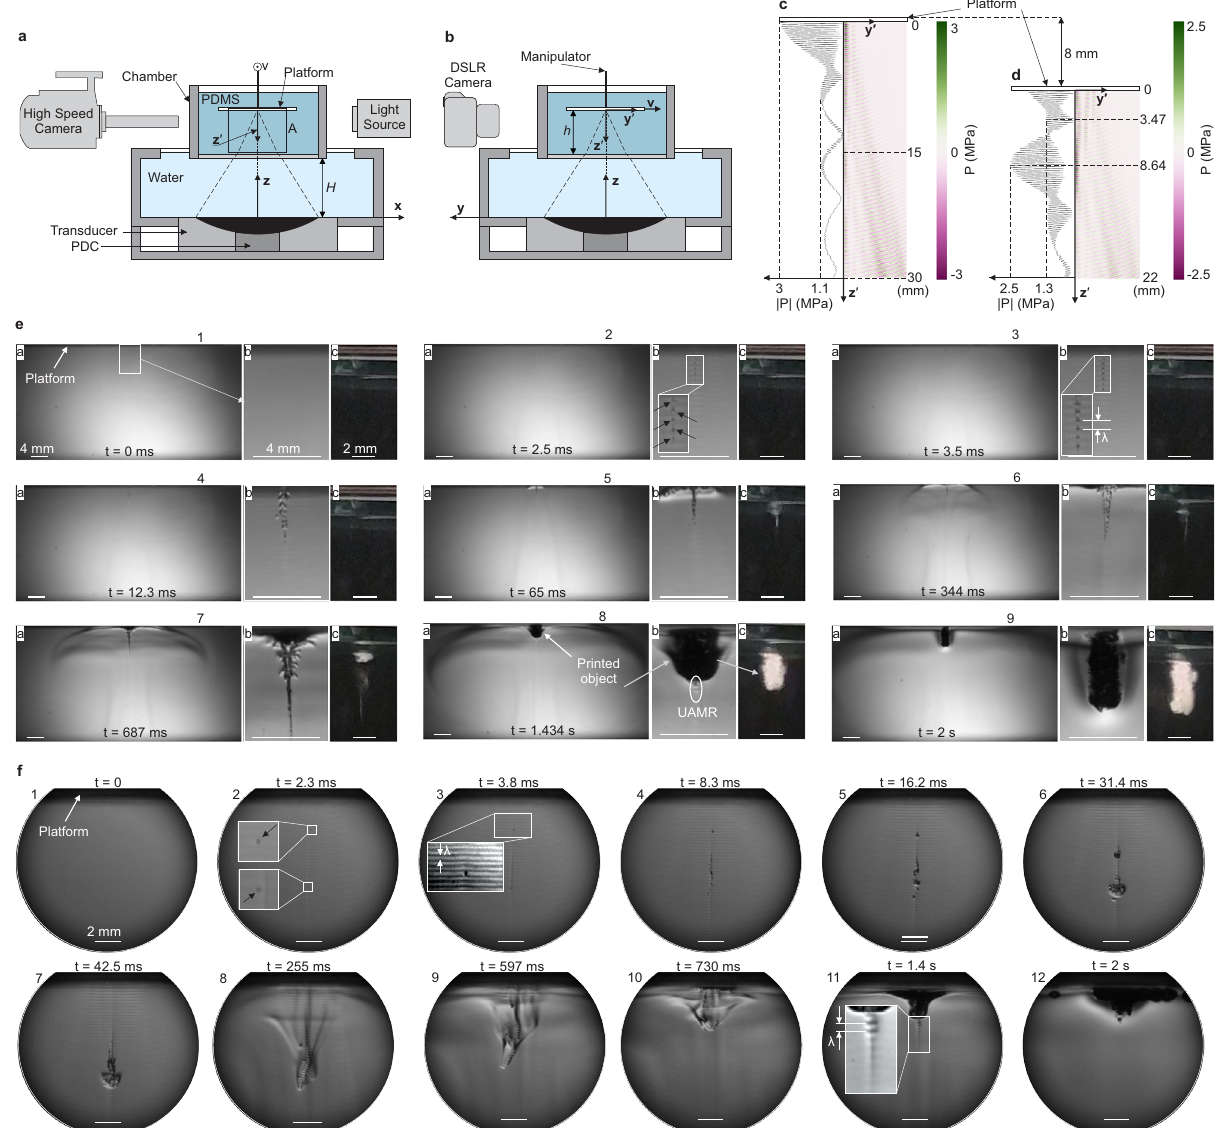
Fig. 2 Observation of UAMR during insonication of the build chamber. a and b Front and side view of the observation setup which constitutes a high speed and DSLR camera. c and d Acoustic pressure in the build chamber, P , at h = 30 mm and h = 22 mm, respectively. e Footage from high-speed imaging (e1-a to e9-a) of area A and DSLR camera (e1-c to e9-c) for h = 30 mm where the acoustic focal is at the platform location (e1-b to e9-b are the magni fi ed views of e1-a to e9-a, respectively) (DSLR: digital single-lens re fl ex, PCD: passive cavitation detector, UAMR: ultra-active micro reactor, PDMS: polydimethylsiloxane). f Footage from high speed imaging (f1-12) for h = 22 mm and v = 0. For all cases, f = 2.15 MHz, DC = 100%, and Power = 210